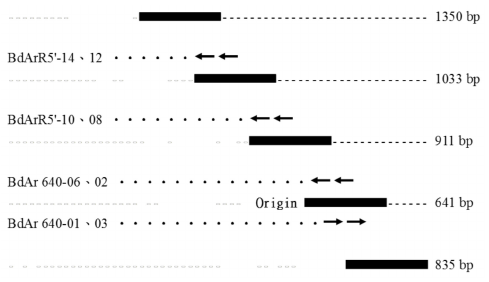
Figure 1. Assembly of the fragments of the fbp1 cDNA cloning in B. dorsalis